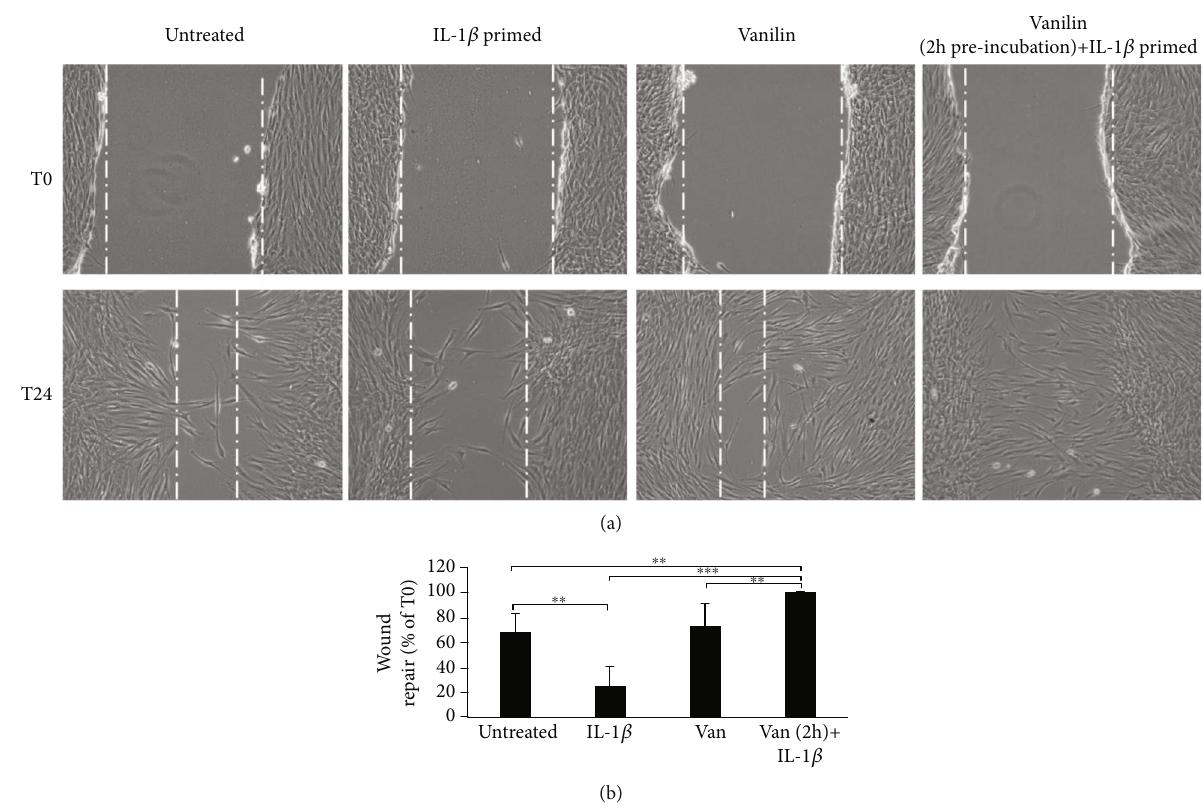
Figure 6: Wound healing of scratched oral fi broblast monolayer photographs and measurement of wound area were made immediately after the scratch (T0) and after 24 h (T24). (a) Representative images of wound-healing assay. (b) Wound repair was evaluated measuring the remaining cell-free area after 24h and expressed as a percentage of the initial wound size (T0) assumed as 100%. ∗∗ p < 0 : 01 ; ∗∗∗ p < 0 : 001 . IL-1 β : IL-1 β -primed cells; Van: Vanillin; Van (2 h)+IL-1 β : Vanillin (2 h pretreatment) plus IL-1 β .